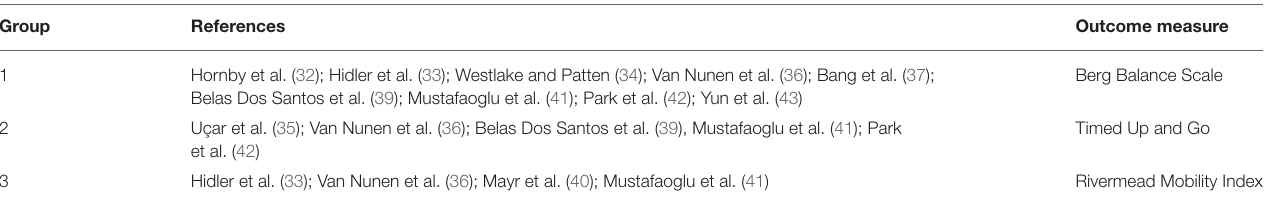
TABLE 3 | Study groups included in the meta-analysis.